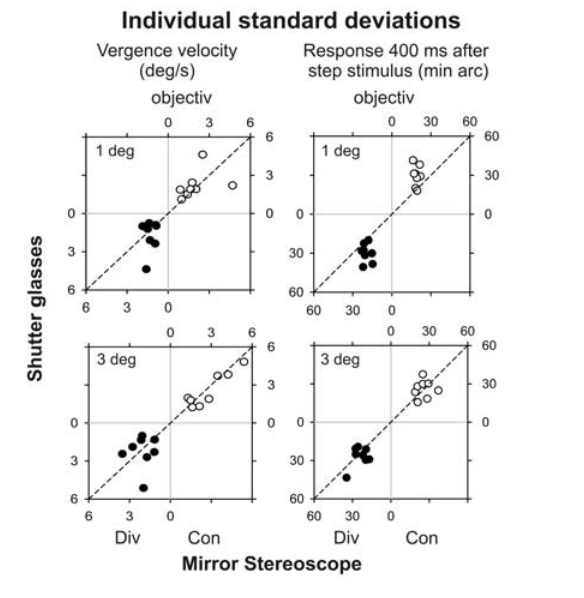
Figure 4. Comparison of shutter glasses and mirror stereo- scope for the individual mean values of 12 subjects for the nonius bias (A) and the fixation disparity (B). The Pearson cor- relation coefficient is given and the regression line is included; the identity line is shown as a reference. In fixation disparity, positive (negative) figures represent over-convergence (under- convergence) relative to accurate vergence angle (zero fixation disparity). In nonius bias, positive (negative) figures represent that the upper line has to be shifted physically to the left (right) of the lower line for perceived